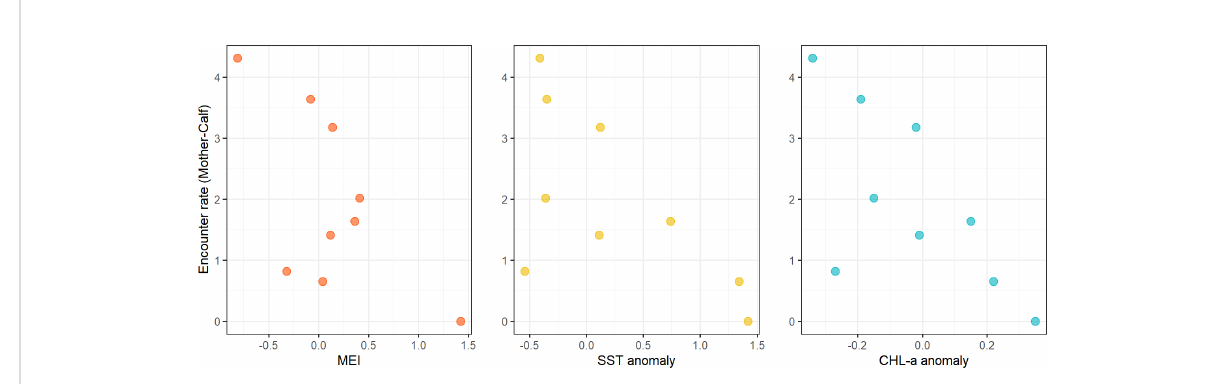
FIGURE 4 Relationships between encounter rates of humpback whales ’ mother-calf pairs and the averages of the Multivariate ENSO Index (MEI), anomalies of sea surface temperature (SST) and Chlorophyll a concentration